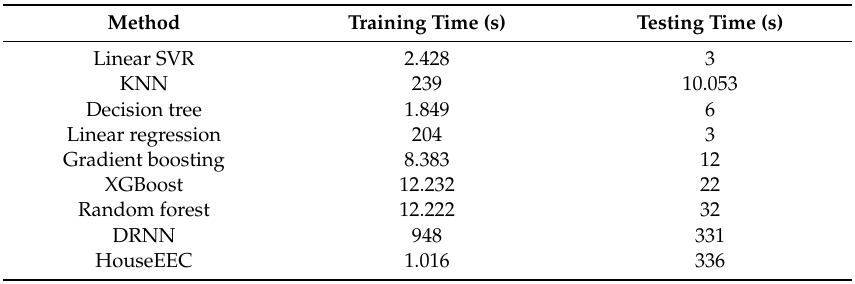
Table 3. Computation time for model training and